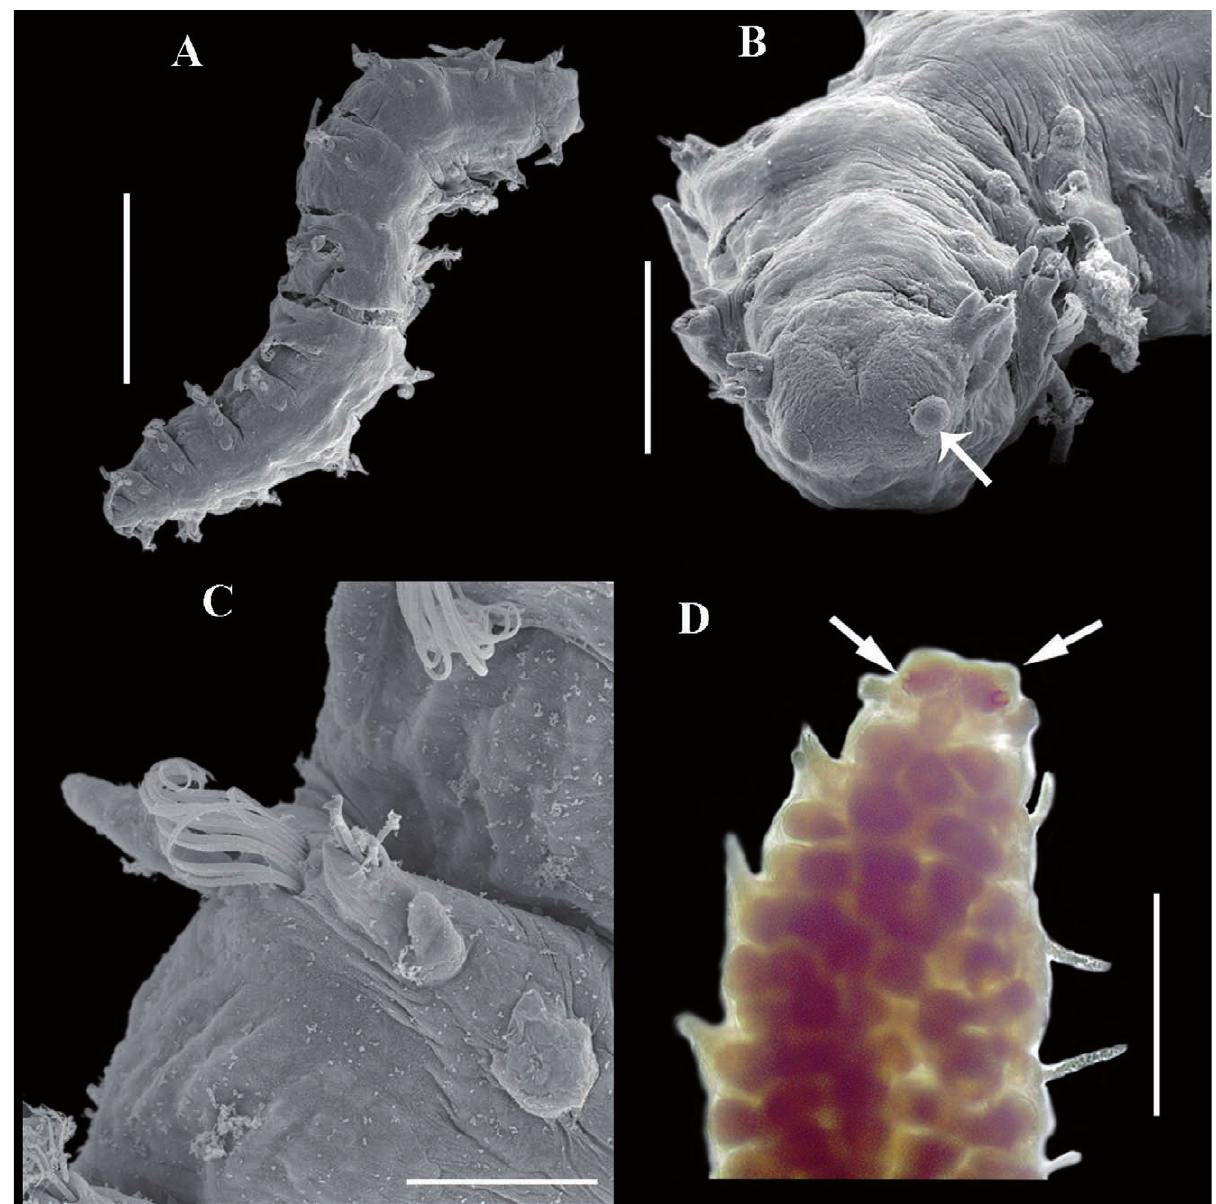
Fig . 3. – SEM micrographs of Haplosyllis aplysinicola n. sp., from Barbados. A, female reproductive body. B, detail of cephalic region, arrow points on palps. C, parapodium with swimming and normal chaetae. Light micrograph: D, female stolon with intracoelomic oocytes.